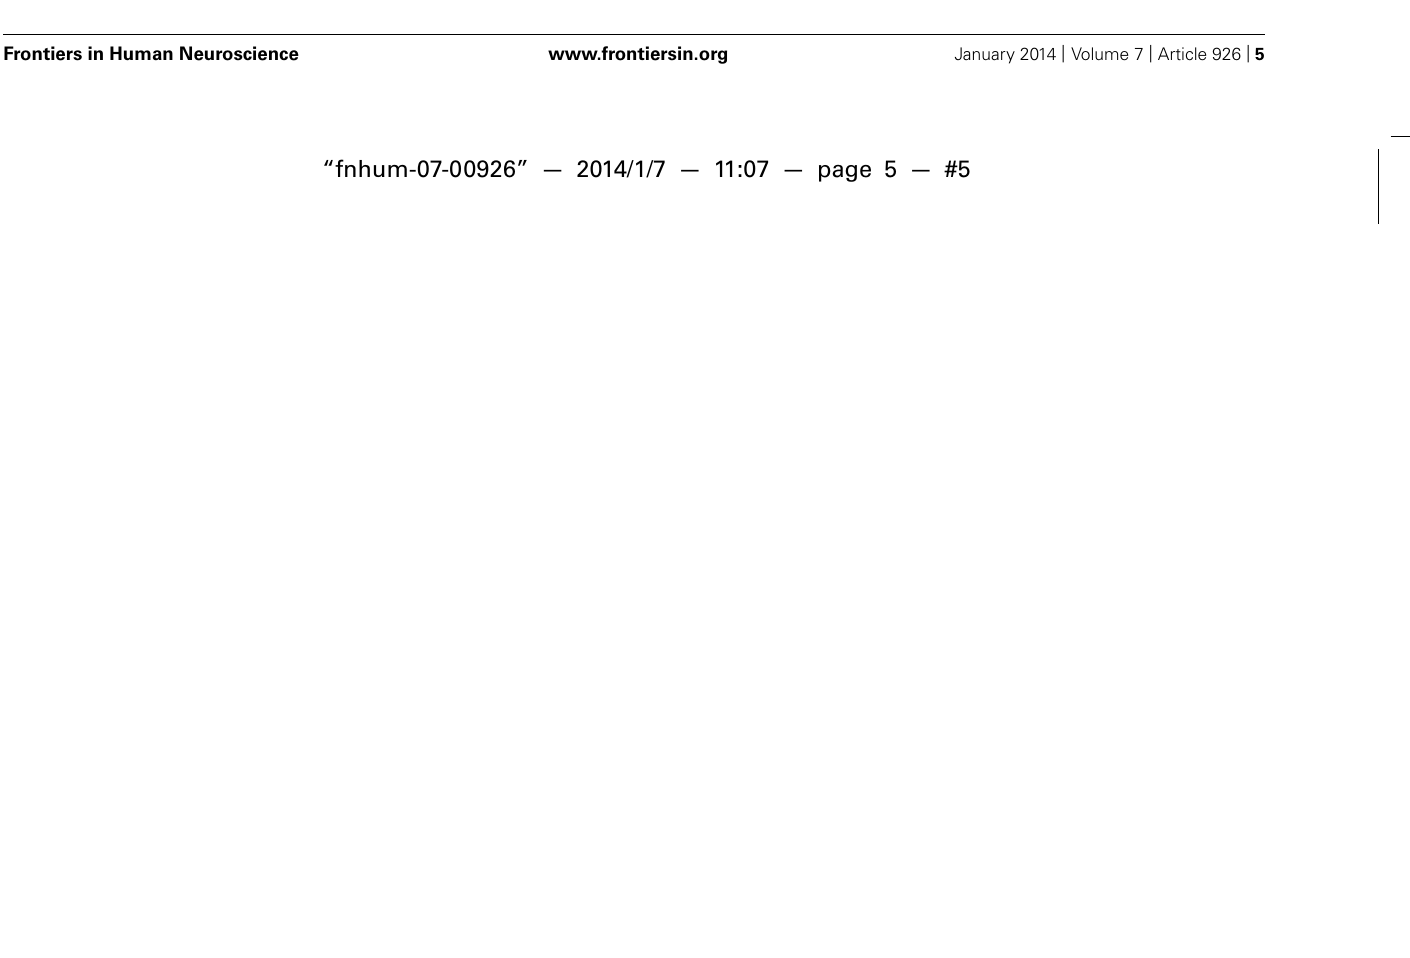
Table 2 | Regression coefficients for the models investigating the amount of change in cognitive performance on the three outcomes that could be explained by music hours/week and other possible factors. Dependent variables and model summaries Visuo-spatialWM (late) VerbalWM (late) Reasoning